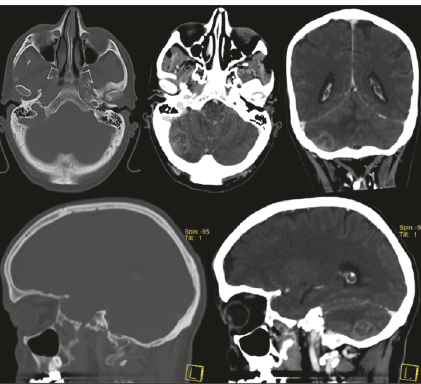
Figure 1: Brain computed tomography scan (bone and brain windows) showing one lesion in the right cerebellum with heterogeneous contrast enhancement.